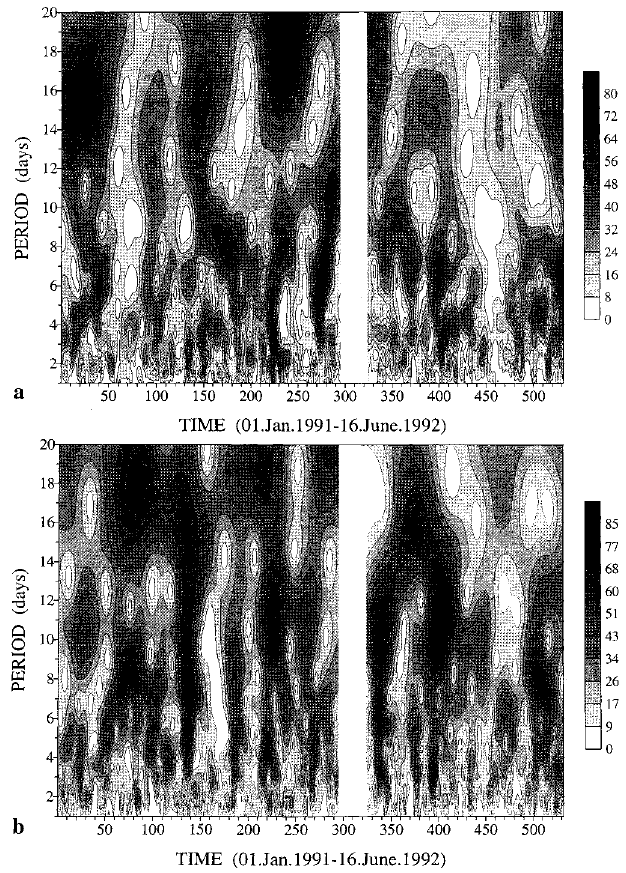
Fig. 9. a The Morlet wavelet transform of the amplitudes of semidiurnal zonal tide for the interval January 1991–June 1992. b The same as Fig. 4a, but for the amplitudes of diurnal zonal tide